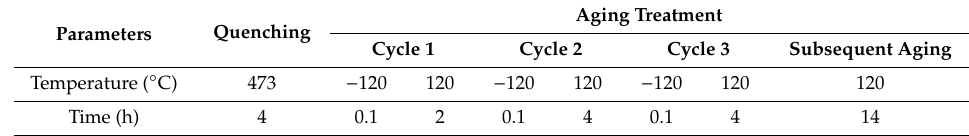
Table 3. Processing parameters of the T6-DCT treatment.